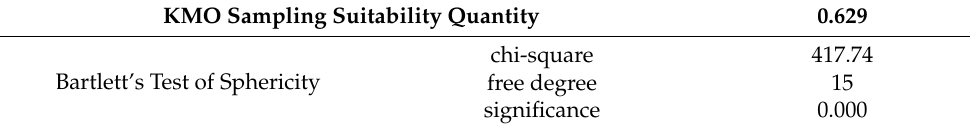
Table A4. KMO and Bartlett Test on Output Index.